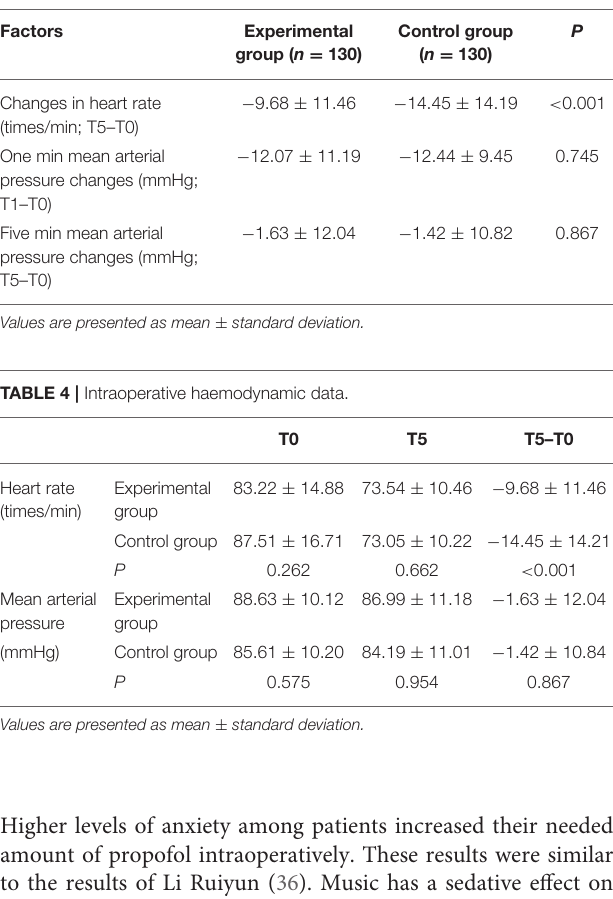
TABLE 3 | Intraoperative haemodynamic data.